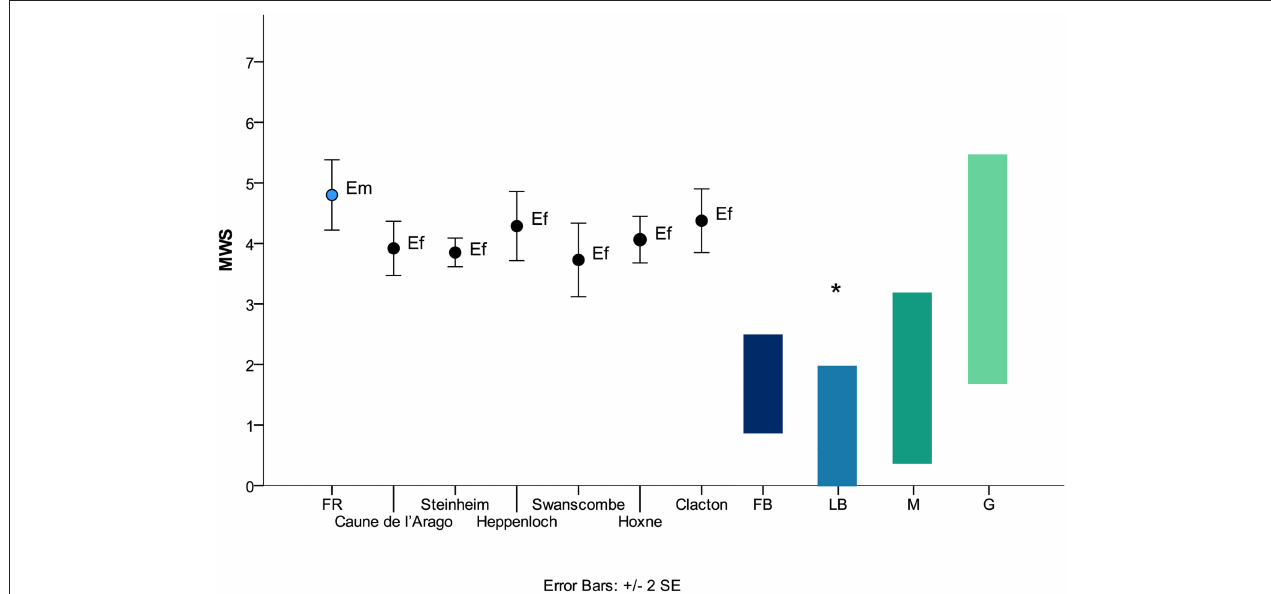
FIGURE 5 | Mesowear results of fossil stenonid equids and extant ungulates. Modern ungulates data from Fortelius and Solounias (2000) (diet information according to the radical classification; minute abraded brachydont species have been included), Rivals and Semprebon (2010). Caune de l’Arago, Steinheim, Heppenloch, Swanscombe, Hoxne and Clacton data from Rivals et al. (2015a), Rivals and Lister (2016) and Rivals and Ziegler (2018). MWS, mesowear score; CSG, Coste San Giacomo; Ez, Equus senezensis aff. E. sen. stehlini ; Es, Equus stenonis ; Eb, Equus bressanus ; FB, fruit browsers; LB, leaf browsers; M, mixed feeders; G, grazers; *, Heterohyrax brucei